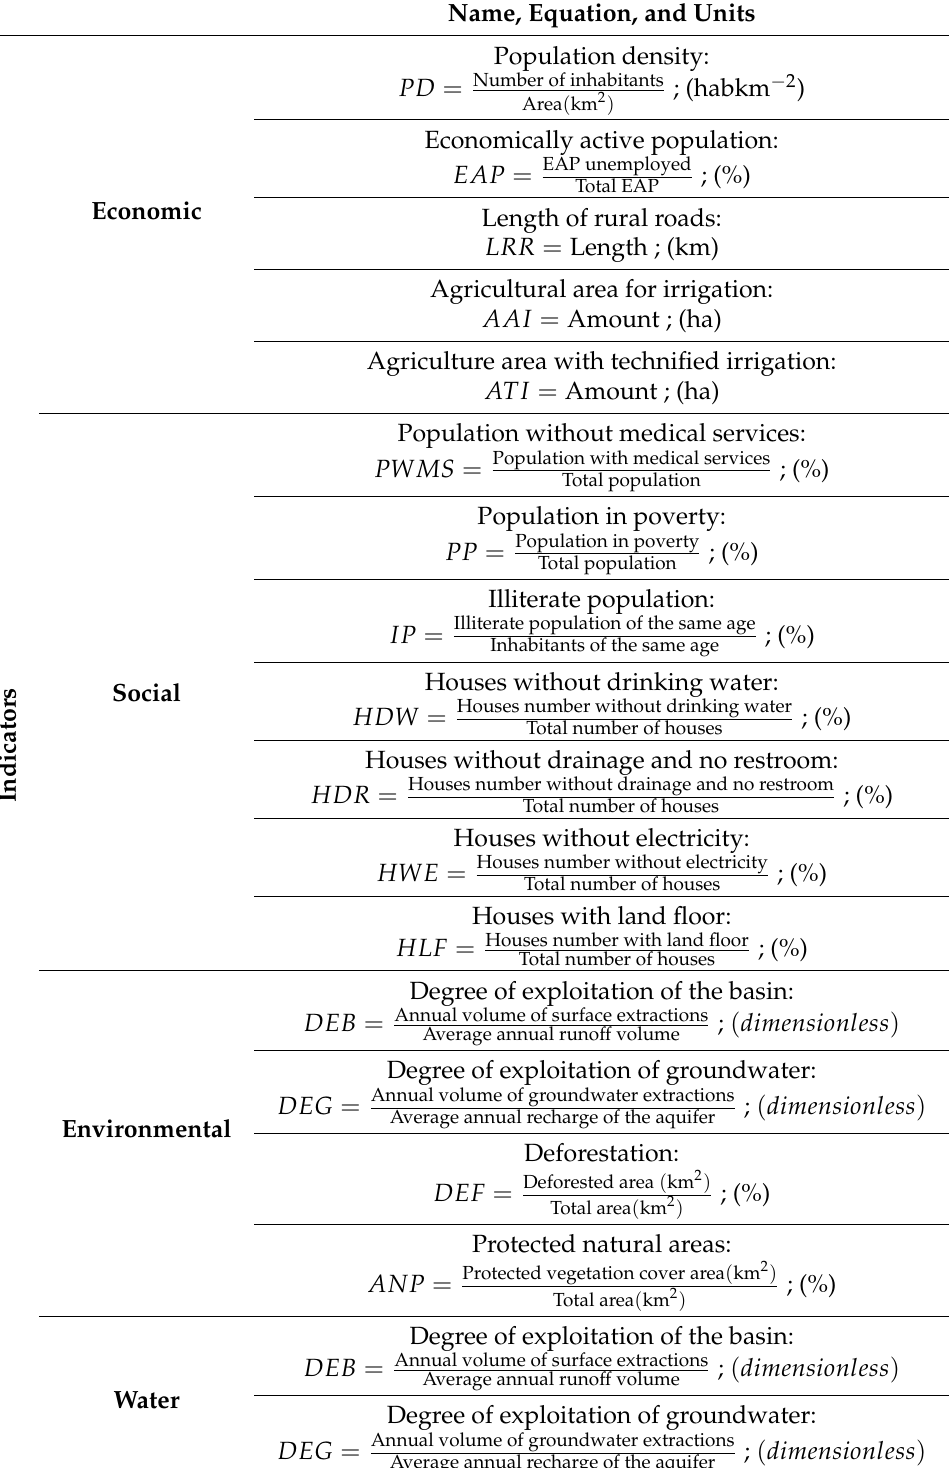
Table 1. Equations and sources of information used in the calculation of indicators